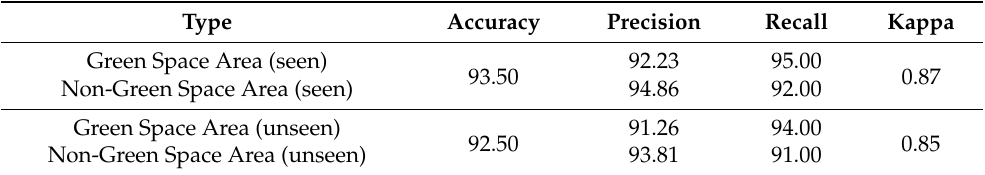
Figure 5. Examples of deep learning classification of non-green space areas. Note: for clarity, callout balloons are added in this paper but are not present on the actual web page. Table 2. The assessment results of individual classifications by using deep learning.